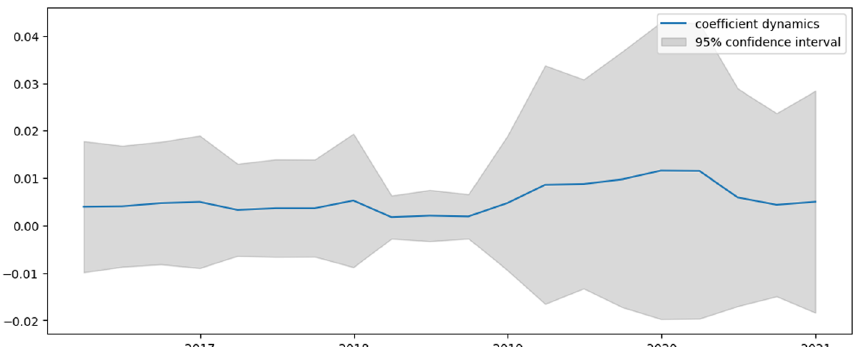
Fig. 10 Intercept dynamics for Alibaba revenue